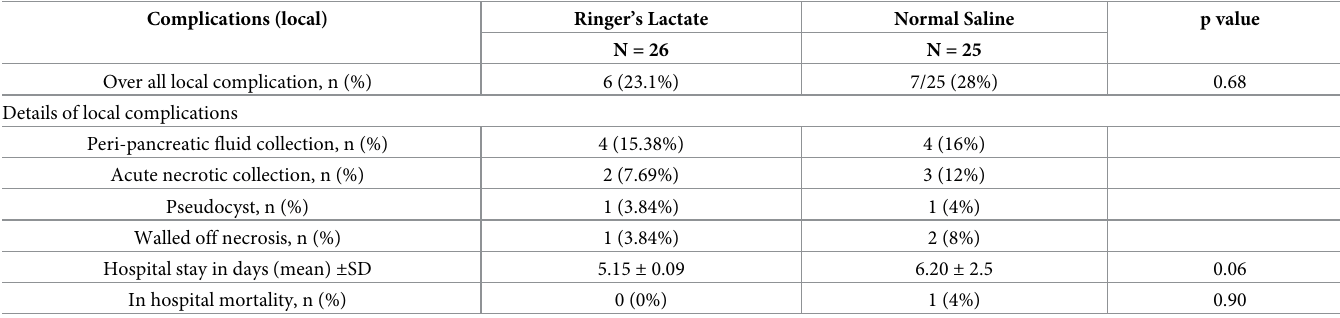
Table 2. Comparison of secondary outcomes in the study